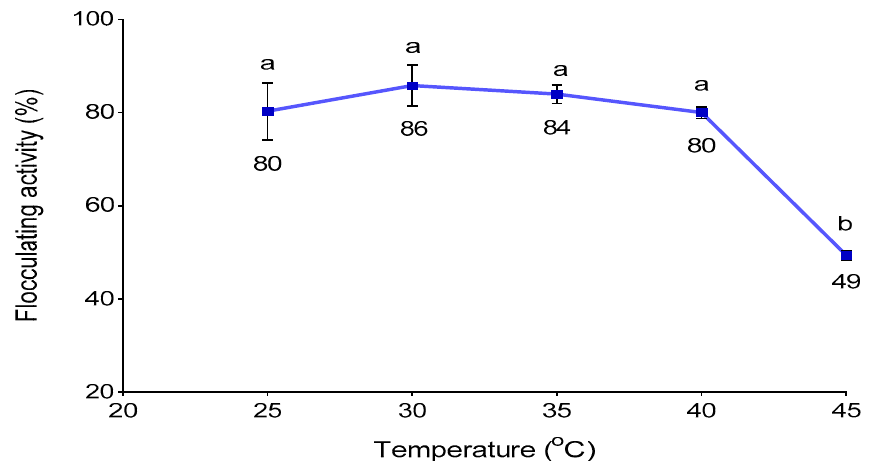
Figure 2. E ff ect of fermentation temperature on flocculating activity di ff erent letters (a & b) denotes Figure 2. Effect of fermentation temperature on flocculating activity d ifferent letters (a & b) statistical significance at ( p < 0.05). denotes statistical significance at ( p < 0.05).